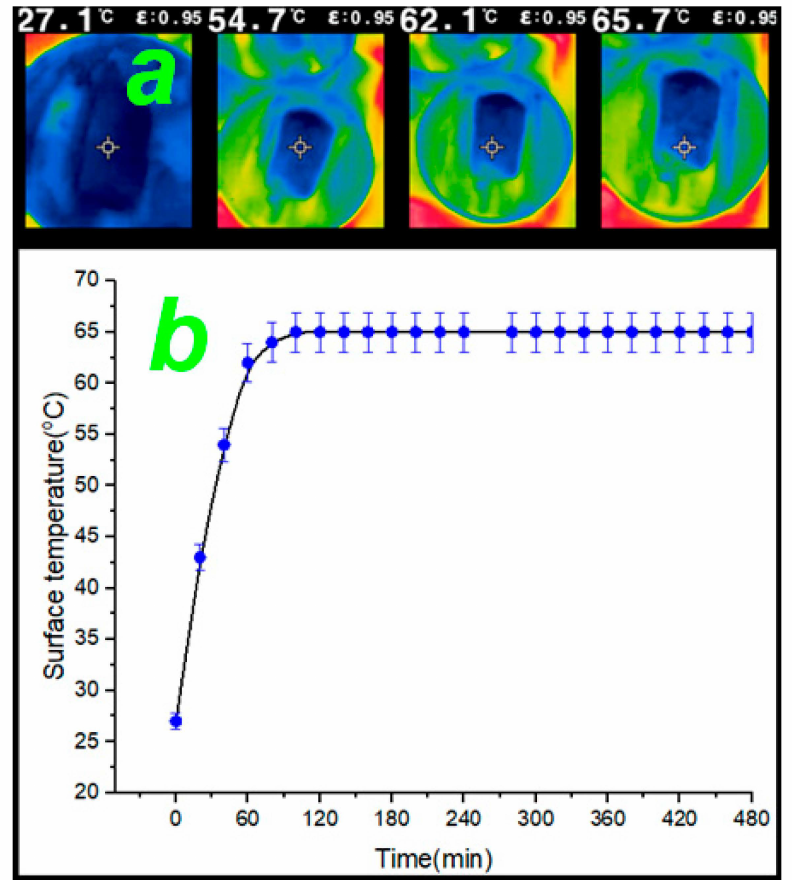
Figure 12. Infrared photos of the surface temperature of the 3D black TiO 2 /Ag/N@rGO absorber under 1-sun solar illumination taken every 20 min ( a ); average surface temperature of the evaporator monitored over the entire 480 min interfacial desalination test ( b